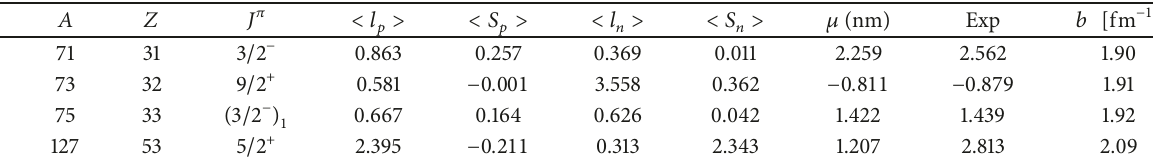
Table 3: List of potential dark matter detectors considered in the present study. The calculated magnetic moments for the ground states of 71 Ga, 73 Ge, 75 As, and 127 I are shown. The results involve the bare gyromagnetic ratios and experimental data are from [44]. The ground state 𝐽 휋 and the harmonic oscillator size 𝑏 are also shown.